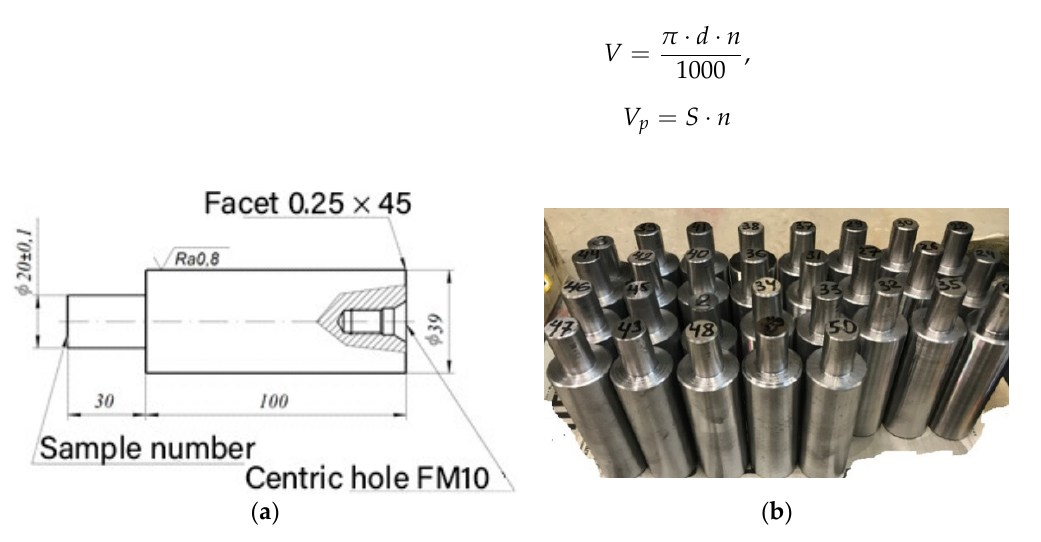
Figure 2. Samples for testing: ( a ) drawing; ( b ) photo.